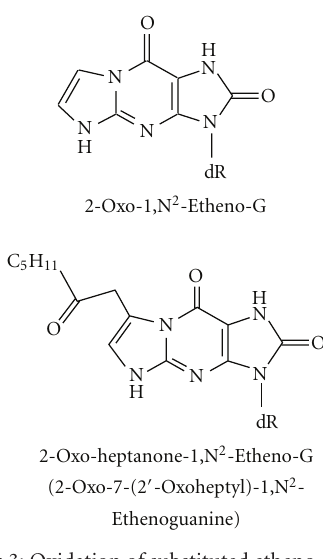
Figure 3: Oxidation of substituted etheno